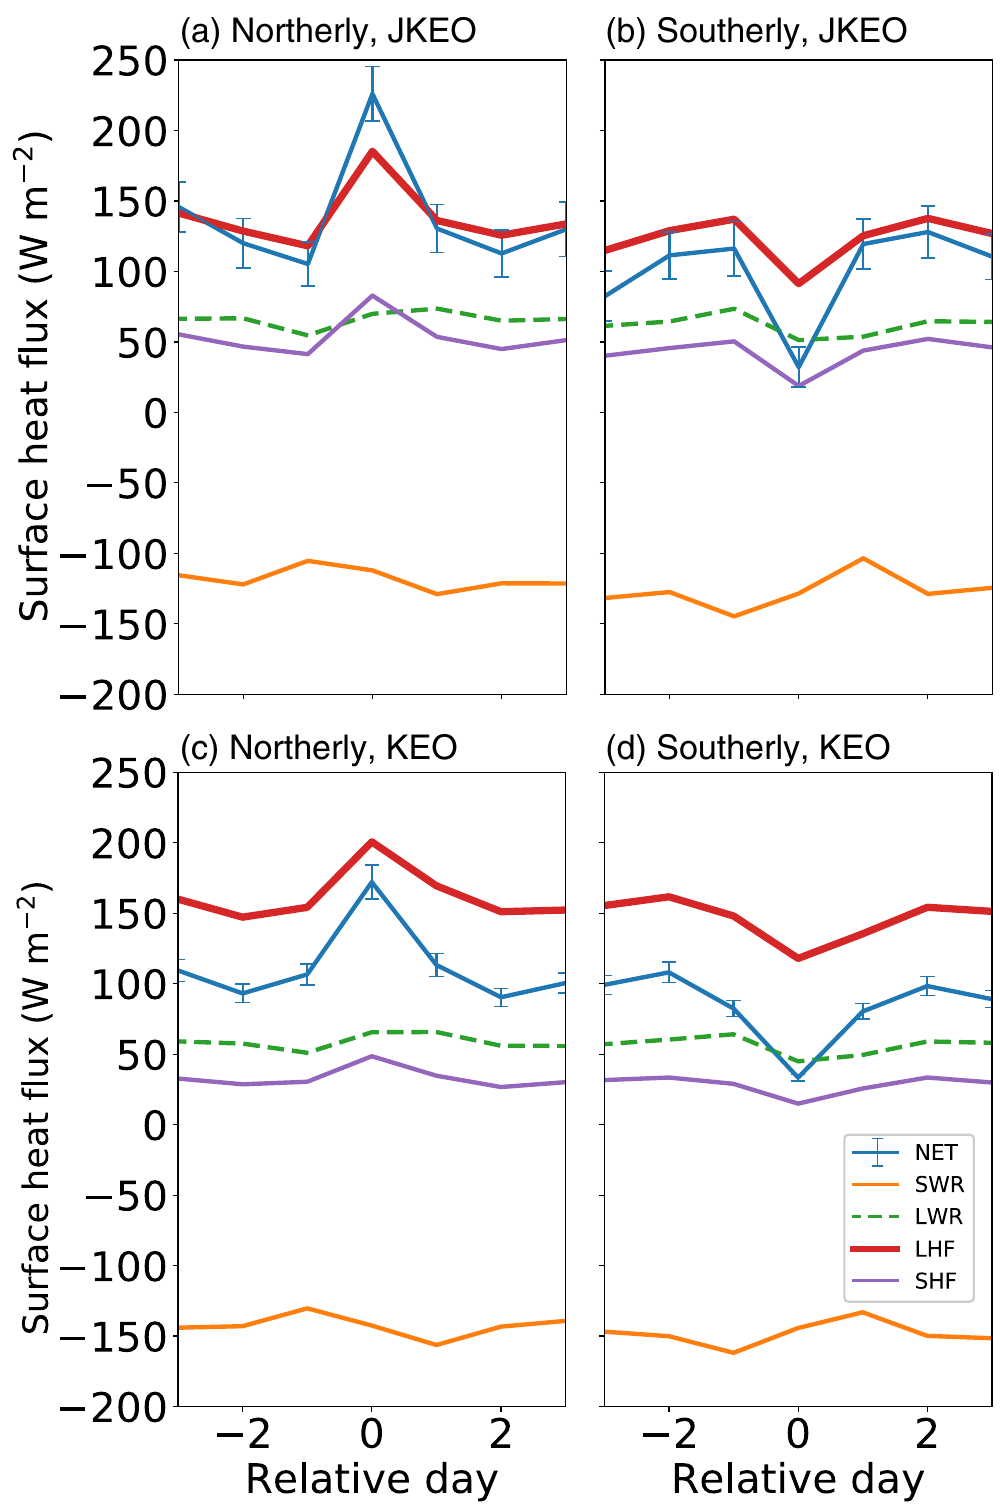
Figure 5. Surface heat flux composition. ( a ) and ( b ) are northerly and southerly composites at JKEO, respectively. ( c ) and ( d ) are northerly and southerly composites at KEO, respectively. NET, SWR, LWR, LHF, and SHF indicate the surface net heat flux, net shortwave radiation, net longwave radiation, surface latent heat flux, and sensible heat flux, respectively. The error bars indicate standard error for